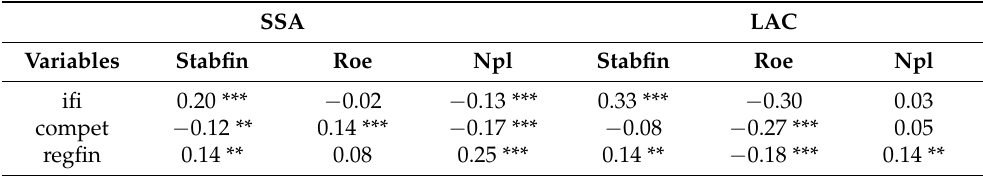
Table 6. Summary of correlations of the main variables of interest. SSA LAC Variables